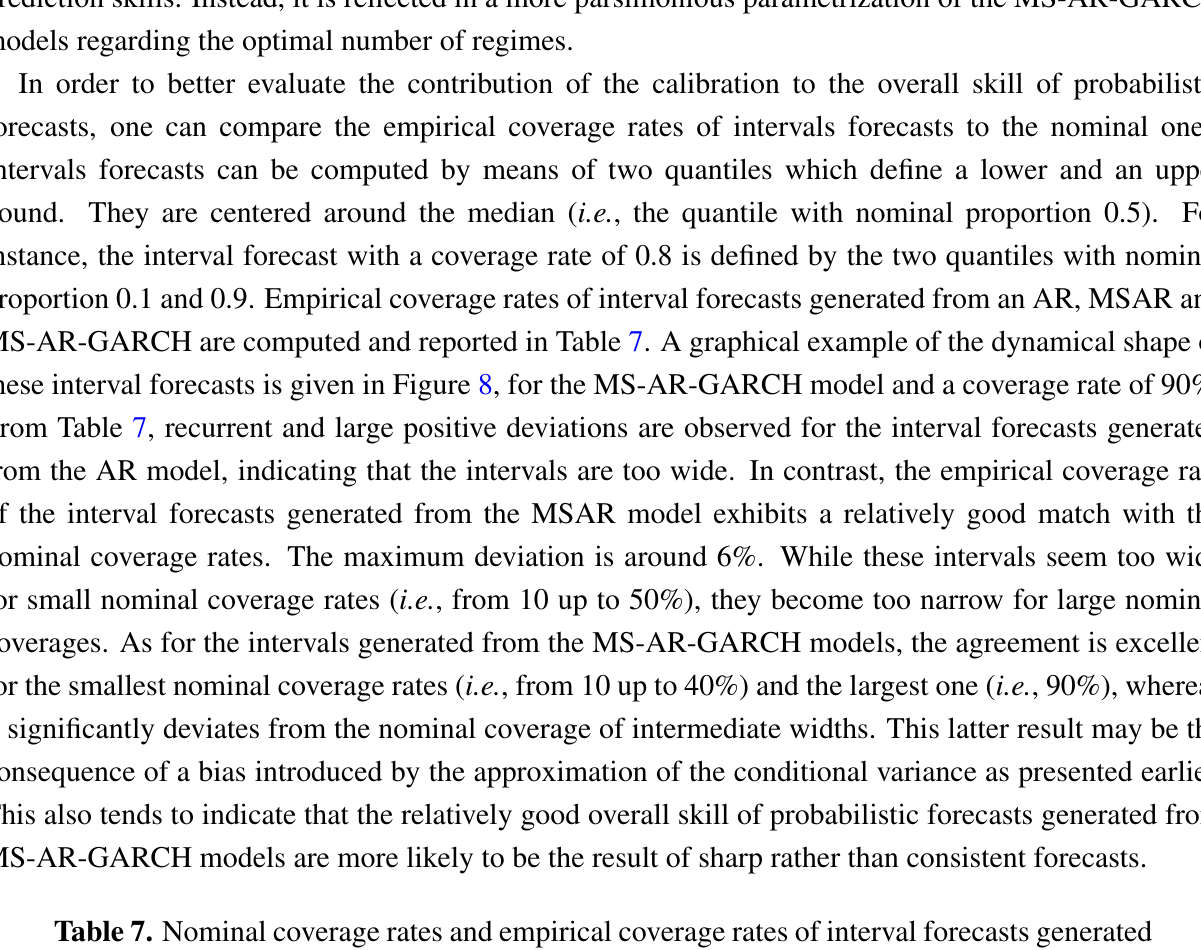
Table 7. Nominal coverage rates and empirical coverage rates of interval forecasts generated by the following three models: AR(3), MSAR(3,3) and MS(2)-AR(3)-GARCH(1,1). The coverage rates are expressed in